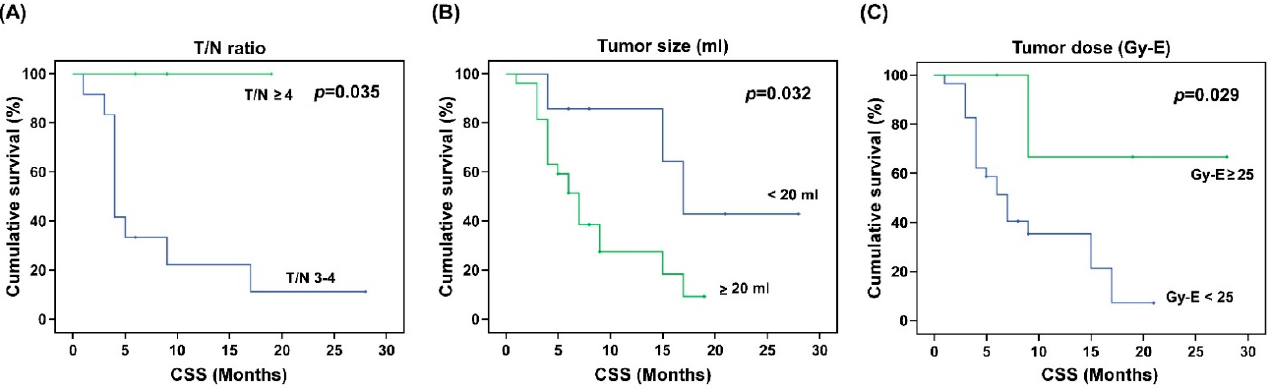
Figure 4. Kaplan–Meier cancer-specific survival curves of patients treated with BNCT according to the T/N ratio, tumor volume,